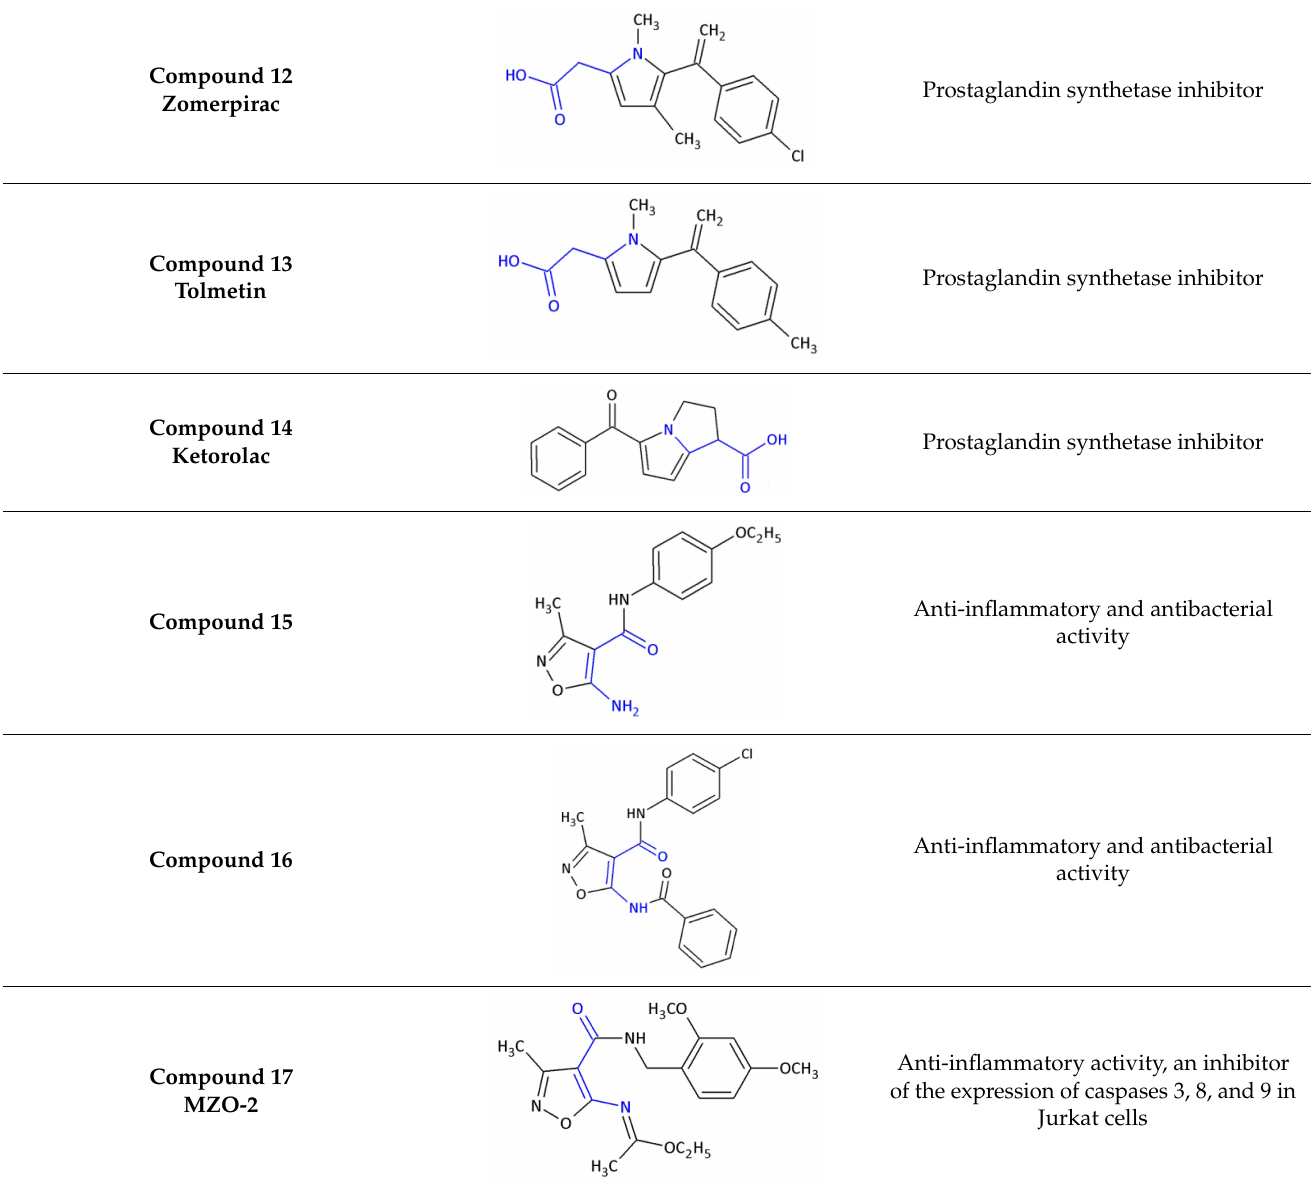
Table 3. Schematic presentation of β 3 and β 2,3 -amino acid heterocyclic derivatives with anti-inflammatory